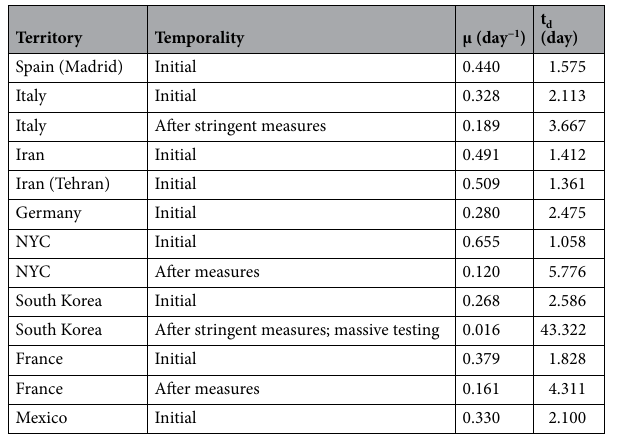
Table 3. Specific infection rates (µ o ) and associated doubling times (t d ) for COVID-19 infection in different geographic regions.